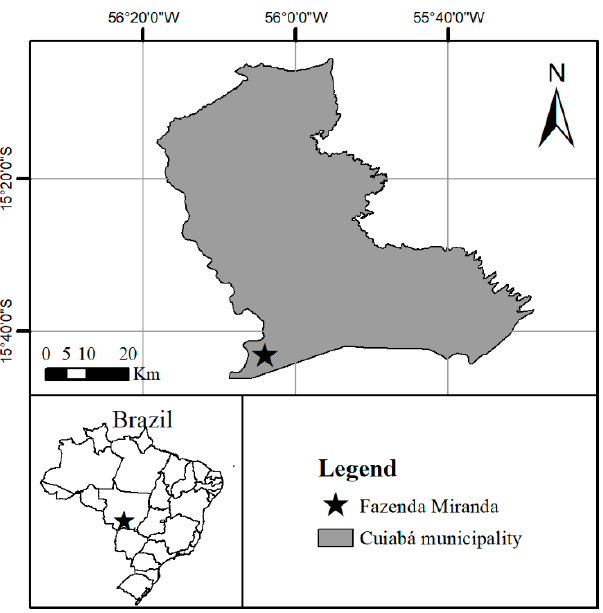
Figure 1. Location of the study site (star) near Cuiabá, Mato Grosso,